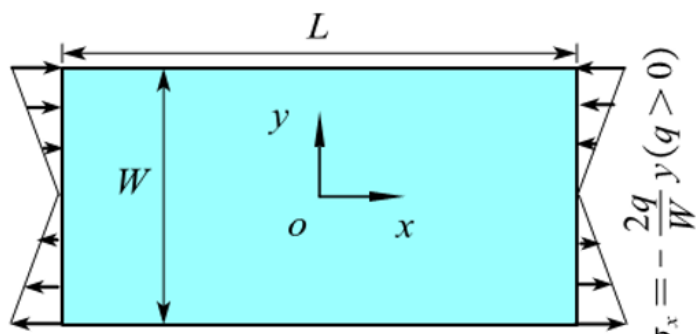
Figure 11. The plate subjected to bending.